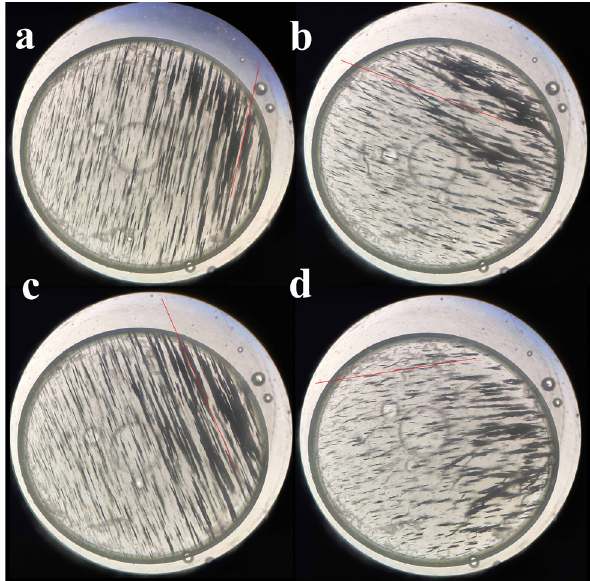
Figure 7: Images of the optical microscope of CS/MNPs - OA microgel droplet ( 1.0% ) . The MNPs - OA particles inside the microgel are orientated by applying an external magnetic fi eld ( red line ) . The direction of the external magnetic fi eld is a ) slightly inclined to the right, b ) slightly inclined to the top, c ) slightly inclined to the left and d ) slightly inclined to the